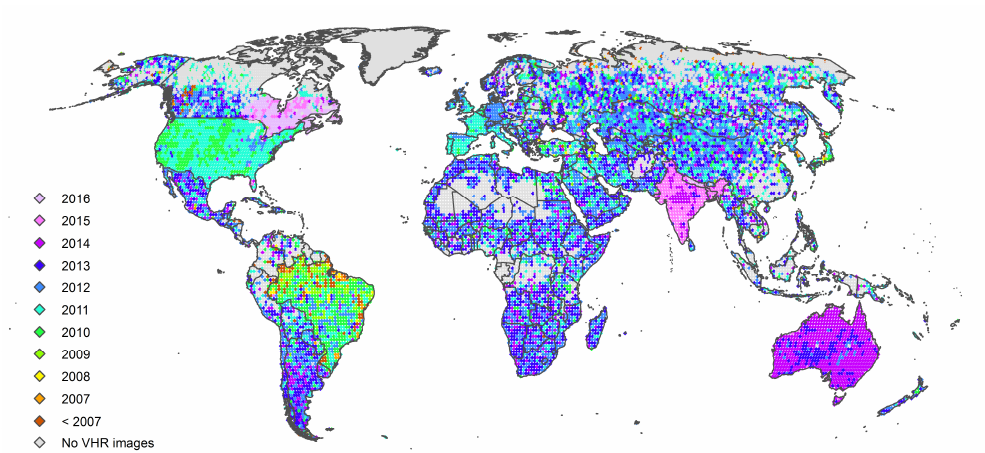
Figure 2. The dates of the most recent VHR satellite imagery (<5 m resolution) available in Microsoft Bing Maps as of January 2017 (Software: Esri ® ArcMap™ 10.1).